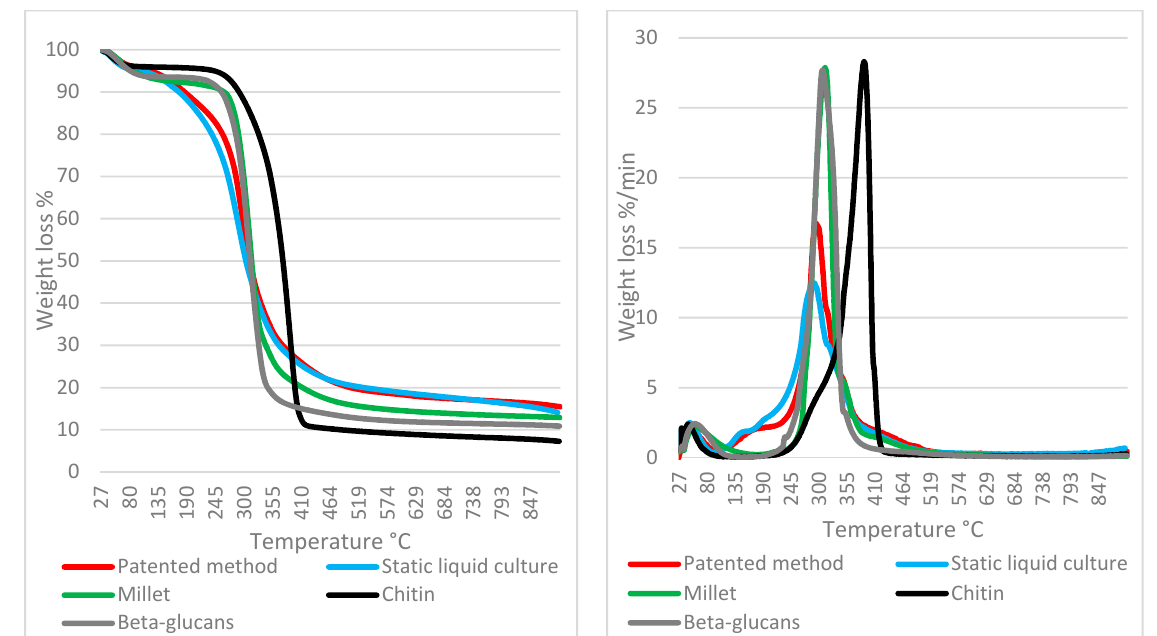
Figure 4. TGA ( left ) and DTGA ( right ) profiles of Fomitopsis iberica (10) (pure mycelium grown in liquid and mat grown on slurry) compared to reference materials.